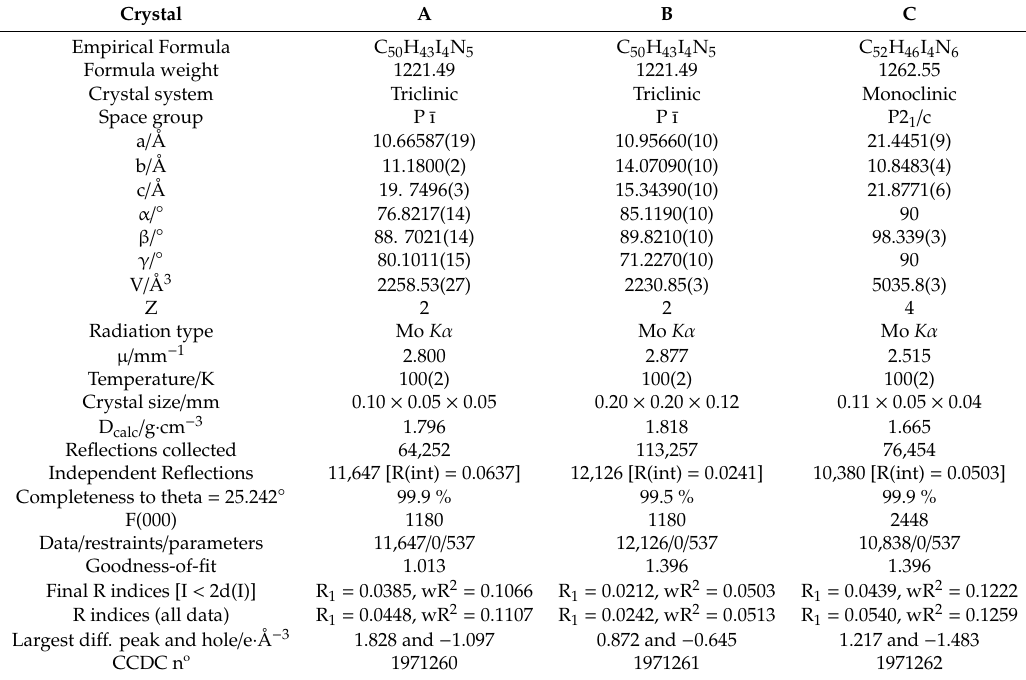
Table 2. Selected crystallographic and refinement data for polymorphs, A and B , and crystal structure C